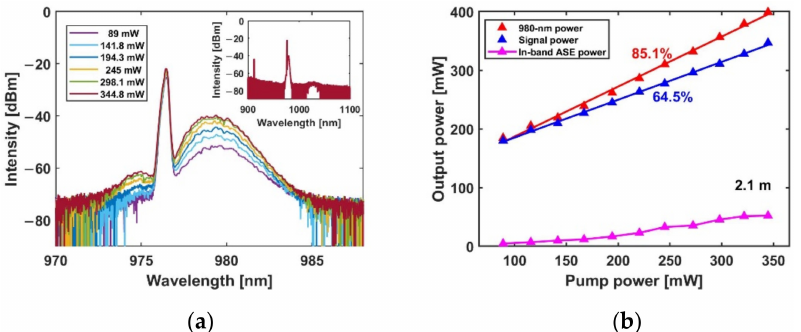
Figure 11. ( a ) The variation of output spectrum with pump power; ( b ) the variations of output power with pump power by using the 976.5-nm LD seed source.